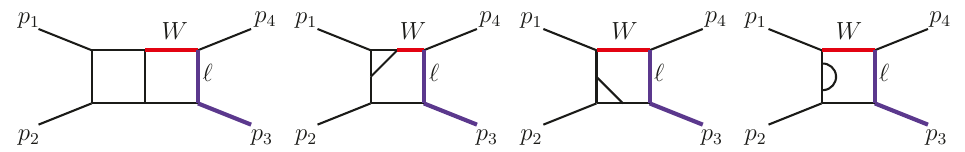
Figure 1. Four topologies of Feynman diagrams for non-factorizable mixed QCD-QED two-loop virtual corrections to q ¯ q 0 → ‘ν . All the diagrams in this paper are drawn by using JaxoDraw